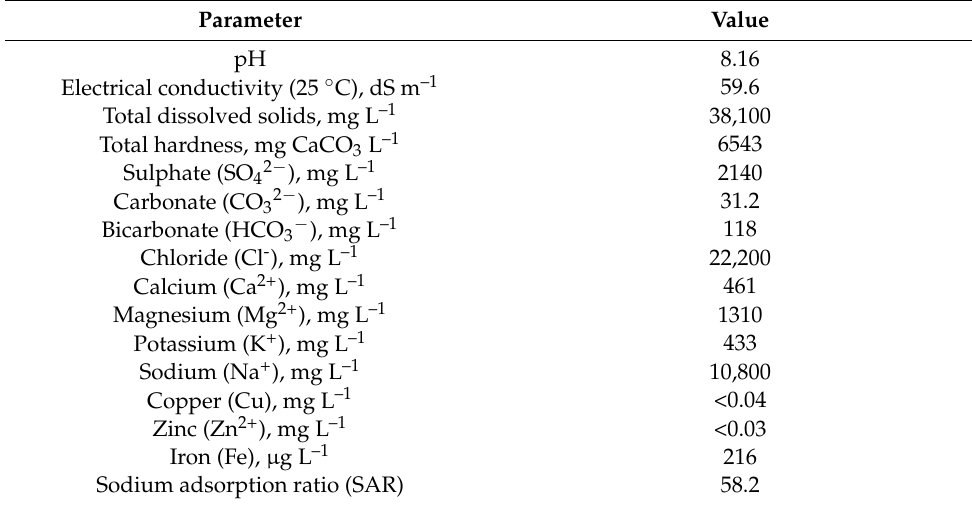
Table 2. Chemical analysis of seawater used for turfgrass irrigation during the stress period (29 July– 13 September 2016).